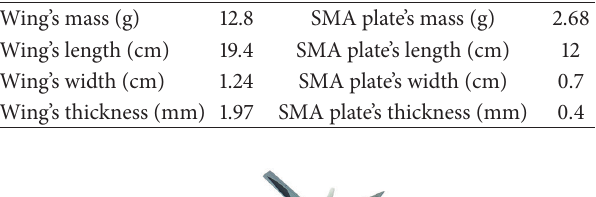
Figure 11: Wingtip’s dynamic response of an uncontrolled SMA composite wing when the mean wind velocity 𝑉 = 6 m/s.